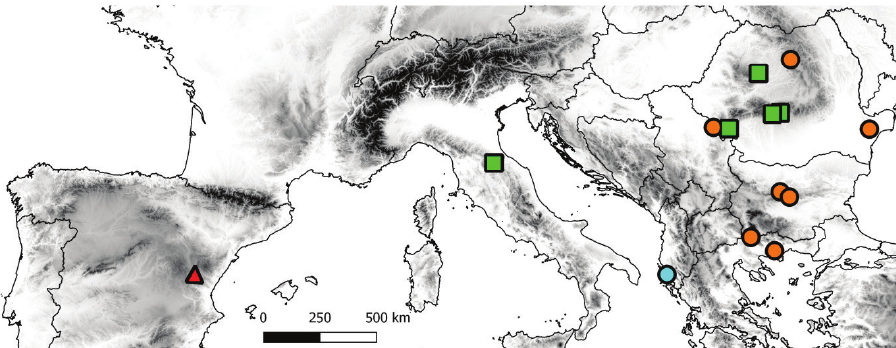
Figure 1. Sampling localities of different Mediotipula species investigated in this study. Tipula (Medi- otipula) cataloniensis Theowald, 1978 (red triangle), T. (M.) stigmatella Schummel, 1833 (orange dots), T. (M.) gjipeensis sp. n. (blue dot), T. (M.) siebkei Zetterstedt, 1852 (green